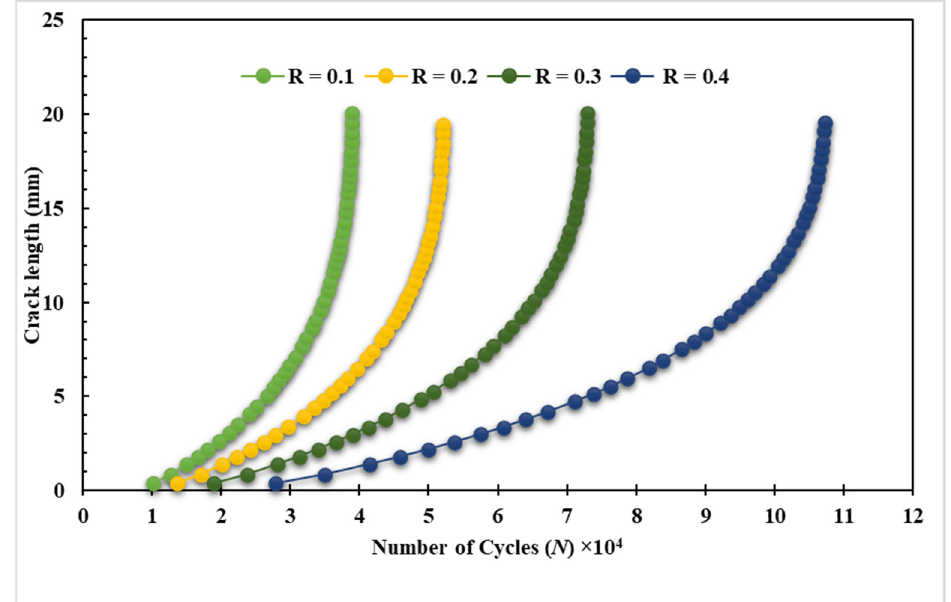
Figure 13. Predicted fatigue life cycles for specimen 3 with stress ratios, R = 0.1–0.4.